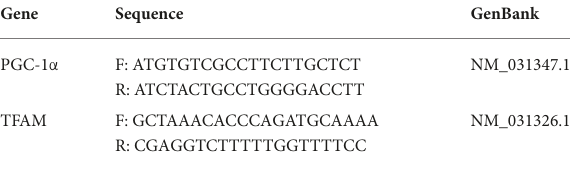
TABLE 1 Rat PGC-1 α and TFAM PCR primer